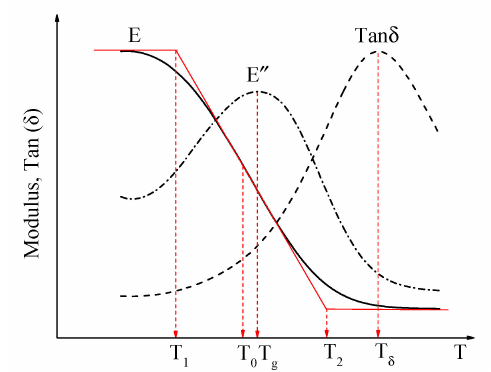
Figure 3. Determination of the glass transition temperature from dynamic